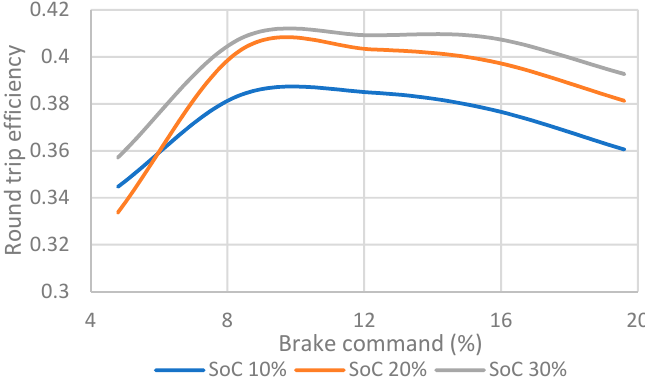
Figure 10. Round trip efficiency of the regenerative braking system.